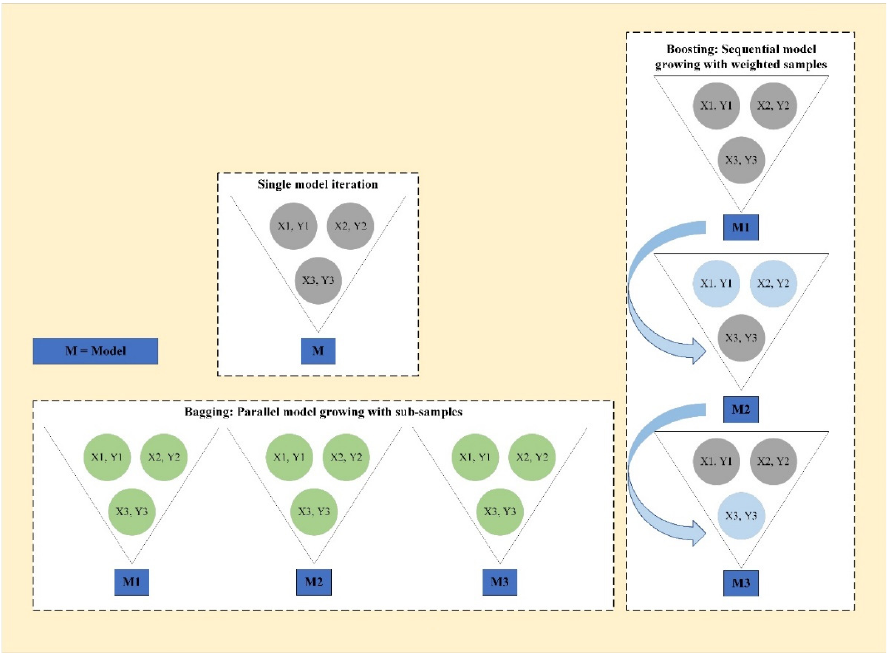
Figure 3. Bagging and boosting process.